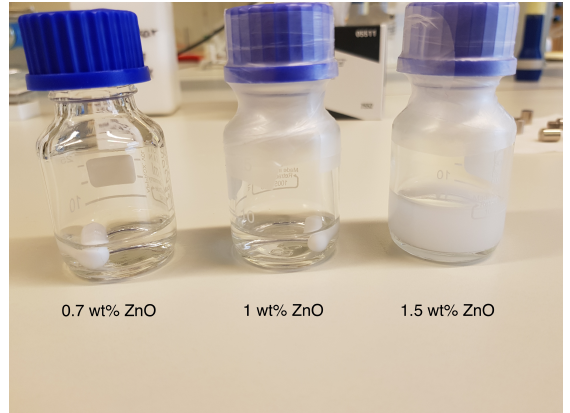
Figure 5. Different concentrations of ZnO in 8 wt %